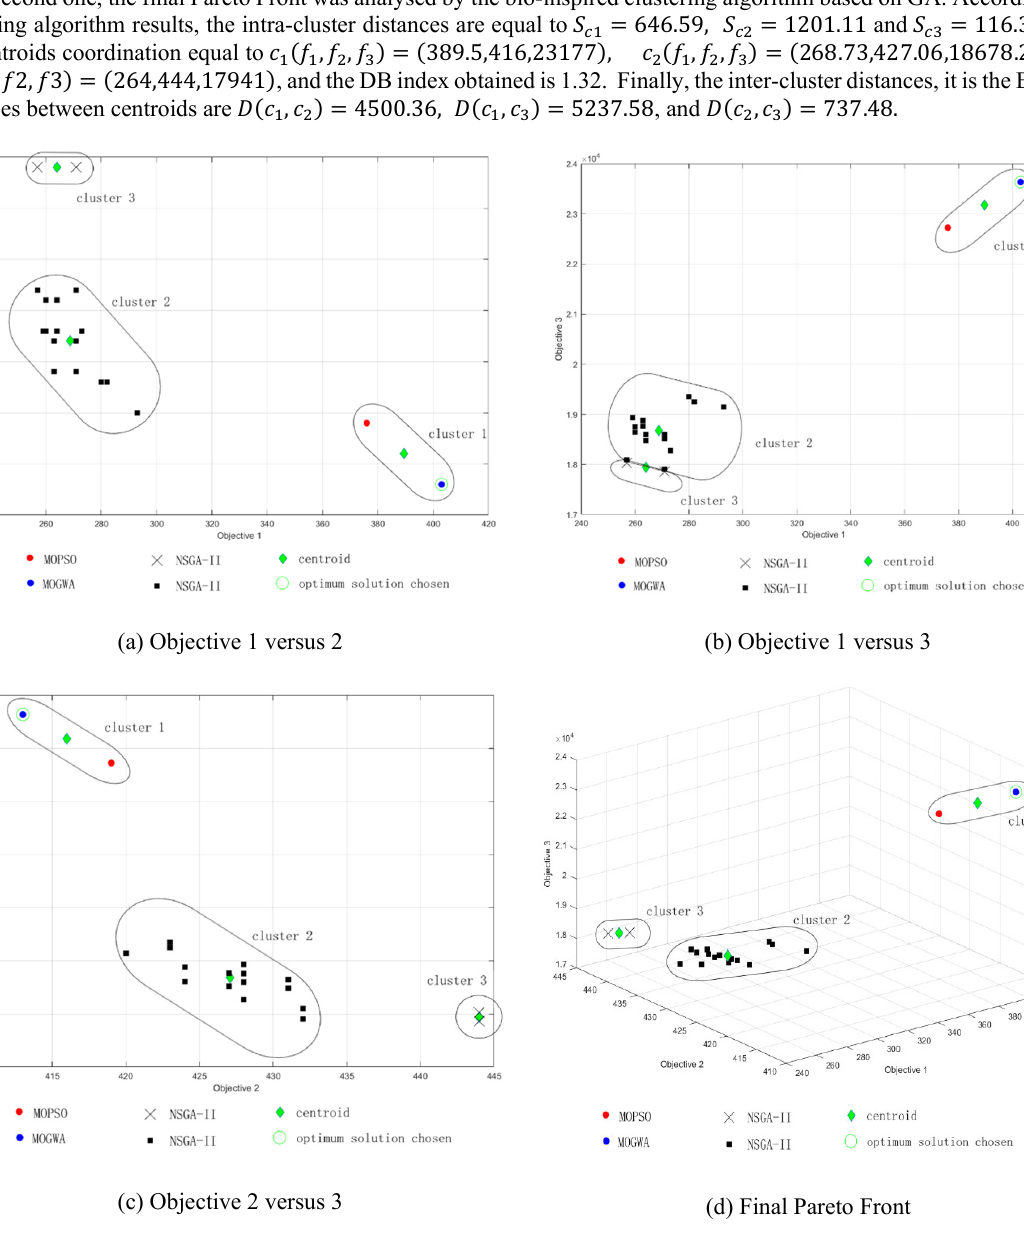
Figure 7. Pareto Front in the second